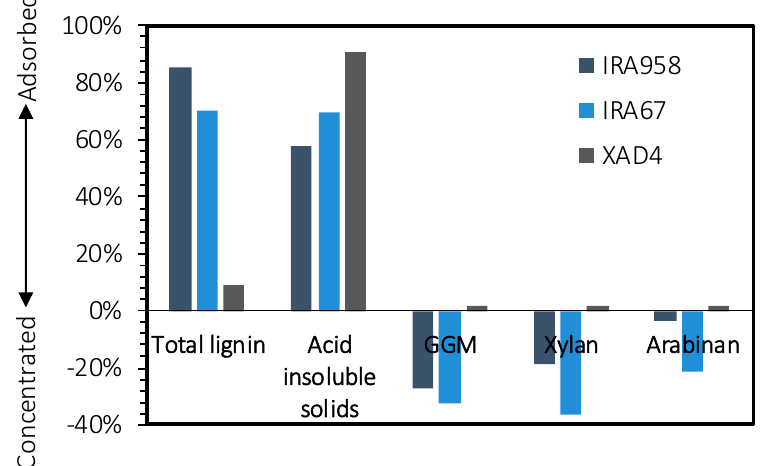
Figure 1. Removal of solutes from the SSL using the resins under examination. Negative removal indicates that the solute was concentrated in the solution.